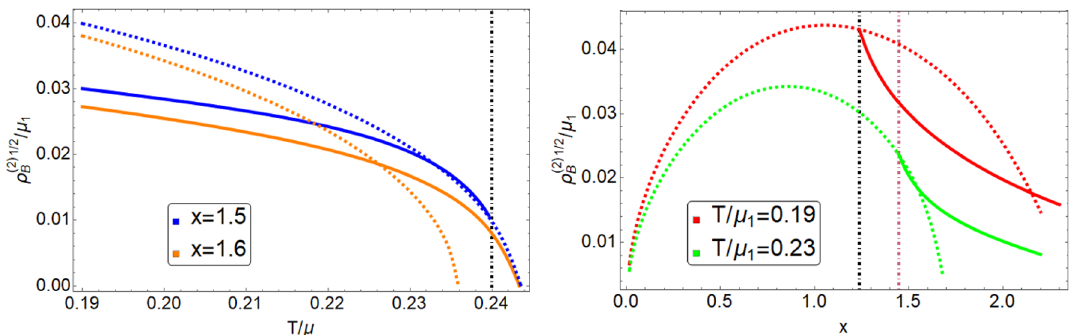
Figure 17 . ρ (2) as the function of temperature T (left) and doping parameter x(right). The solid B curves in color stand for ρ (0) in SSC phase, while the dashed lines in color stand for ρ (2) B absence of SC. The vertical lines denote the location of SSC phase